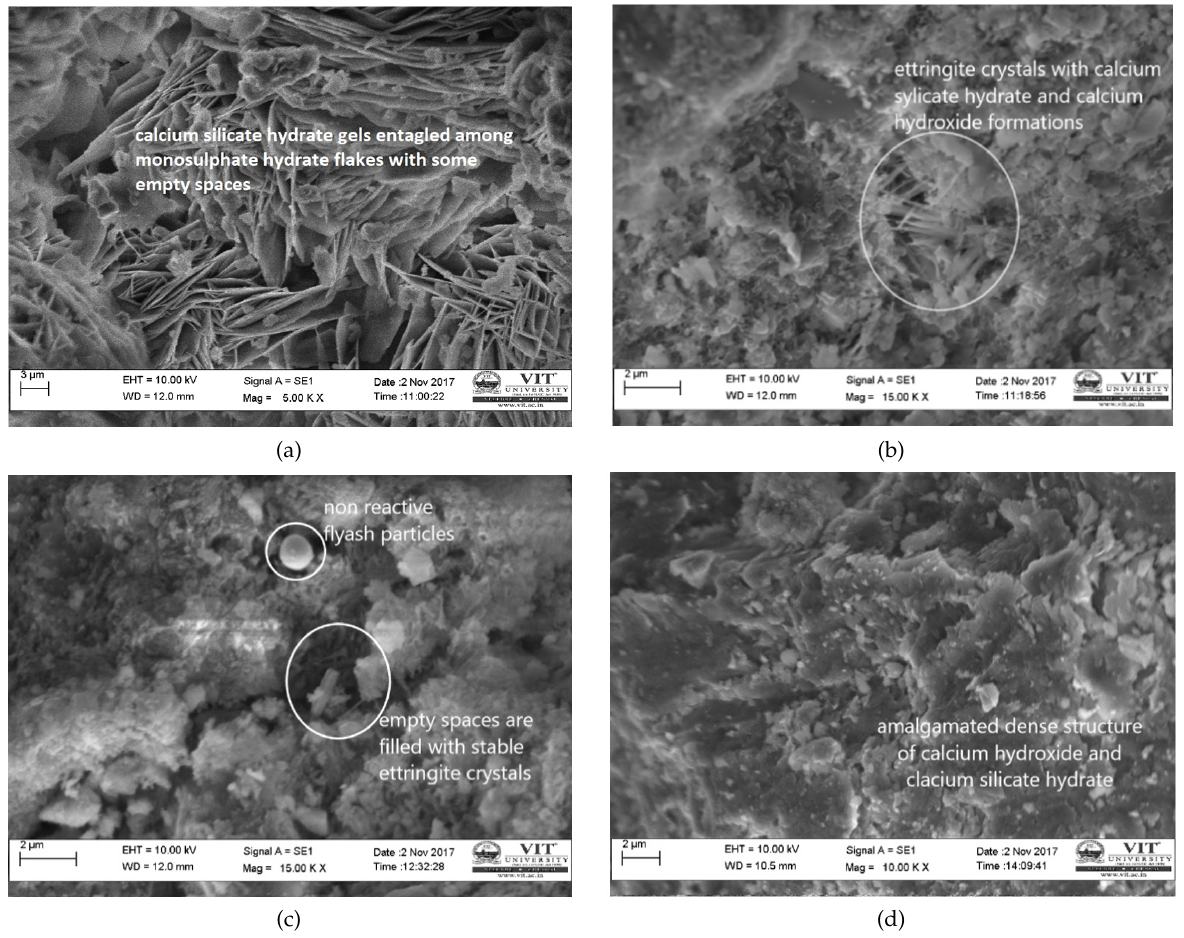
Fig. 10. SEM images of samples cured in seawater (after 365 days